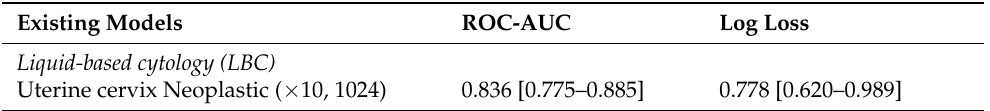
Table 3. ROC-AUC and log-loss scores for existing deep learning models to classify liquid-based cytology (LBC) and histopathology whole slide images